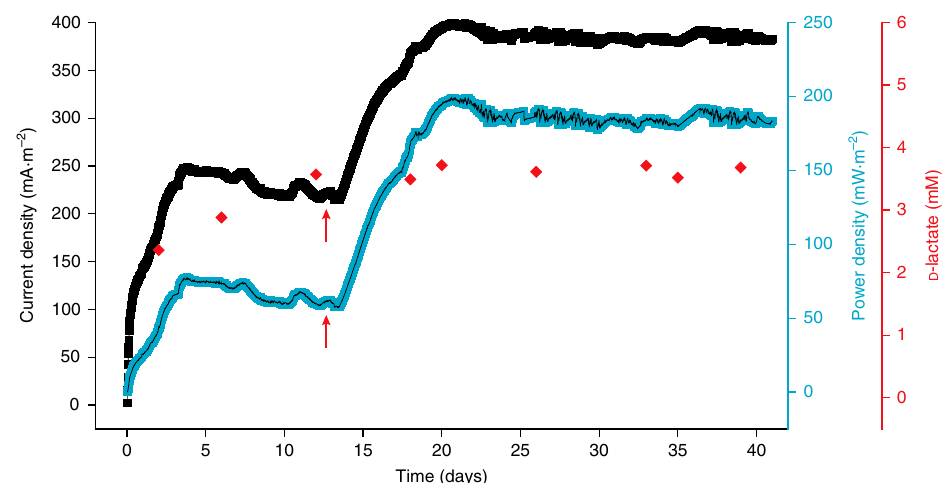
Fig. 6 Achieving long-term steady power output by the spatially temporally separated CLS microbial consortium with medium replenishment. Electrical outputs (current density and power density) from the CLS microbial consortium were shown. The concentration of D -lactate in the cyanobacterial culture was measured at several time points. During the period of 0 ‒ 13th days, 5% LB medium was added to the anodic chamber. From the 13th day onward, the addition of LB medium was decreased to 1% (red arrows indicated). Current density was recorded every 20 min. The data shown in the different curves were from one of the experiments, each contains more than 2800 data points. Source data are provided as a Source Data fi